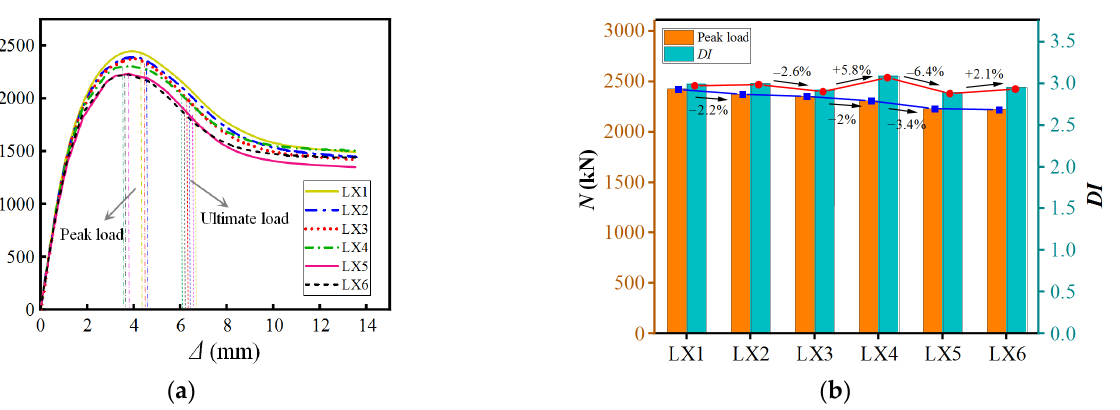
Figure 13. Different spiral rib width–thickness ratio. ( a ) Load–displacement curve ( b ) Performance Changes Note: DI : Ductility factor.